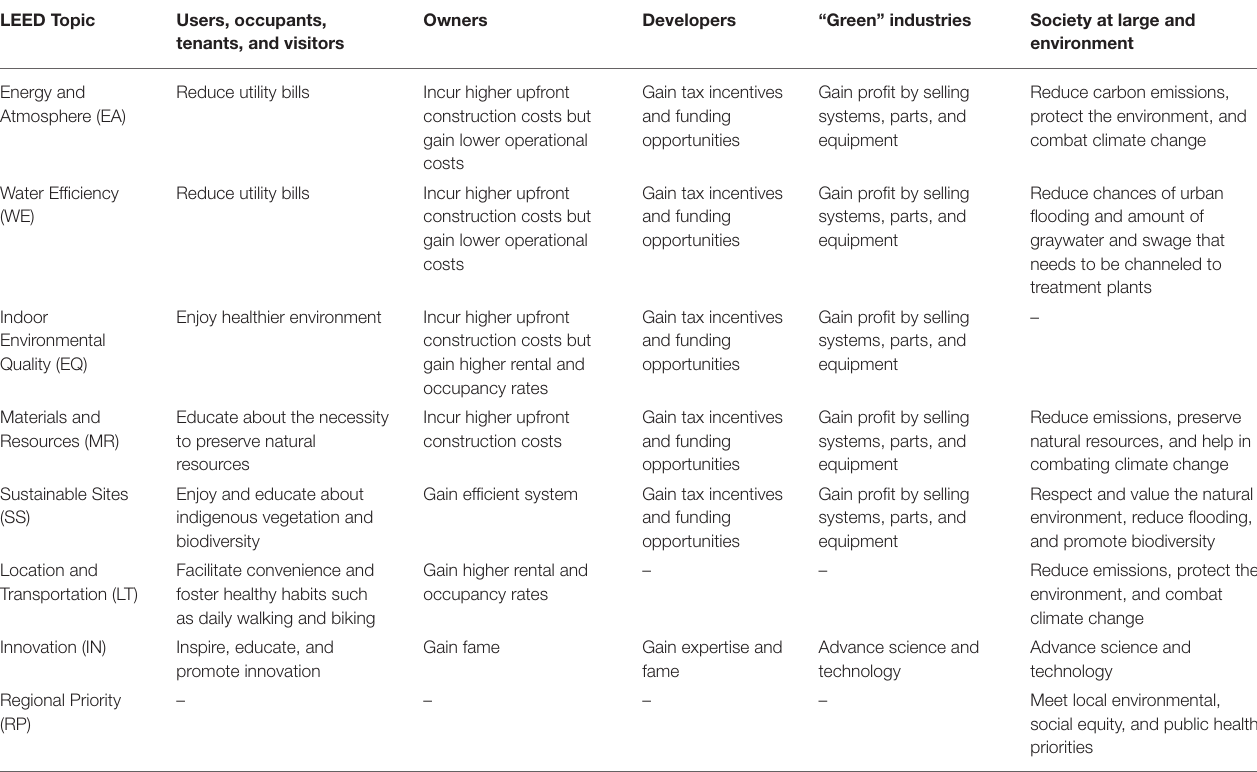
TABLE 14 | Who pays and who gains by employing green features? LEED